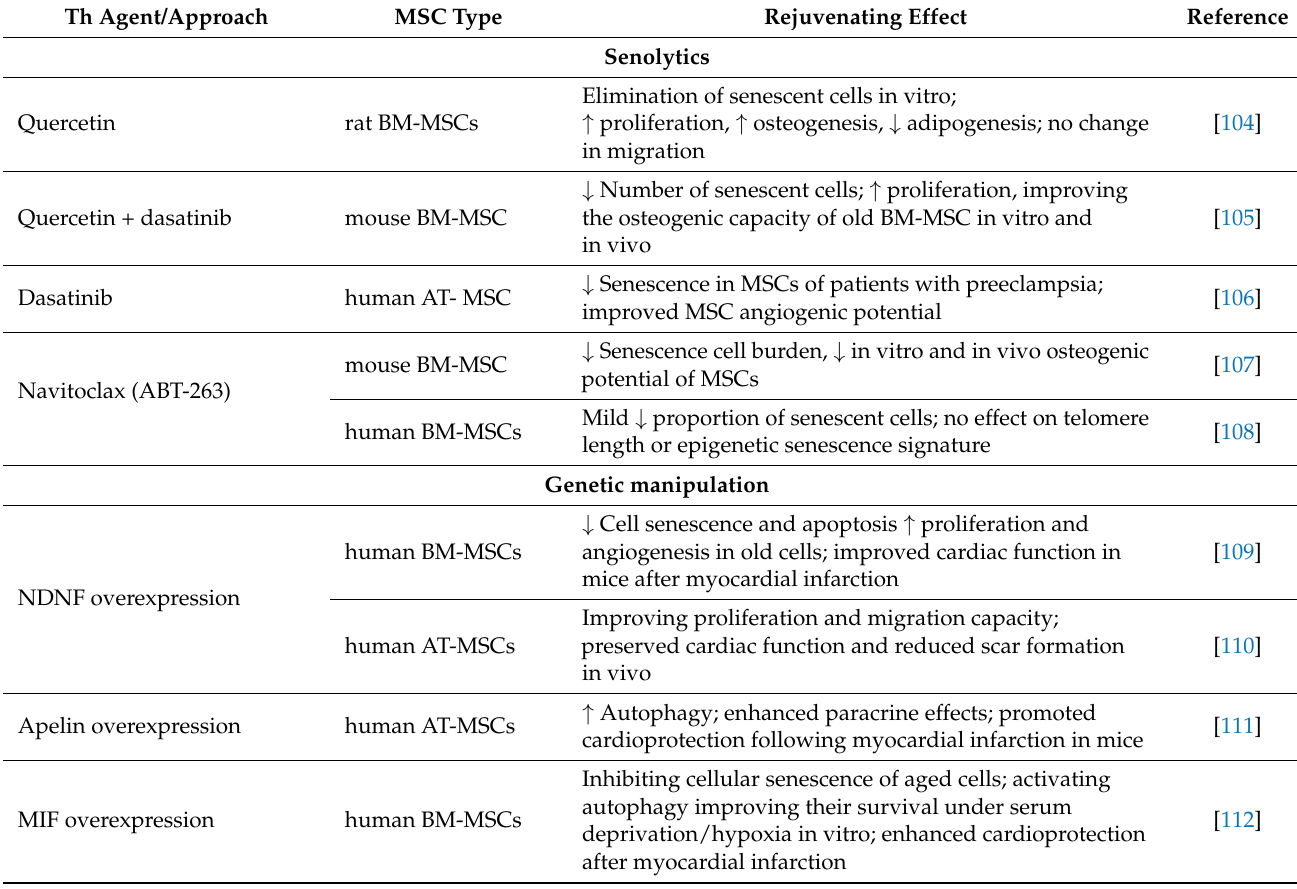
Table 1. Different strategies for the treatment of senescence in